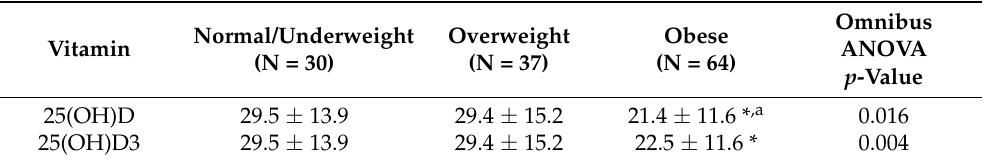
Table 3. Baseline total 25-Hydroxyvitamin D and 25-Hydroxyvitamin D3 by body mass index in adults with history of COVID-19 infection (N = 131).